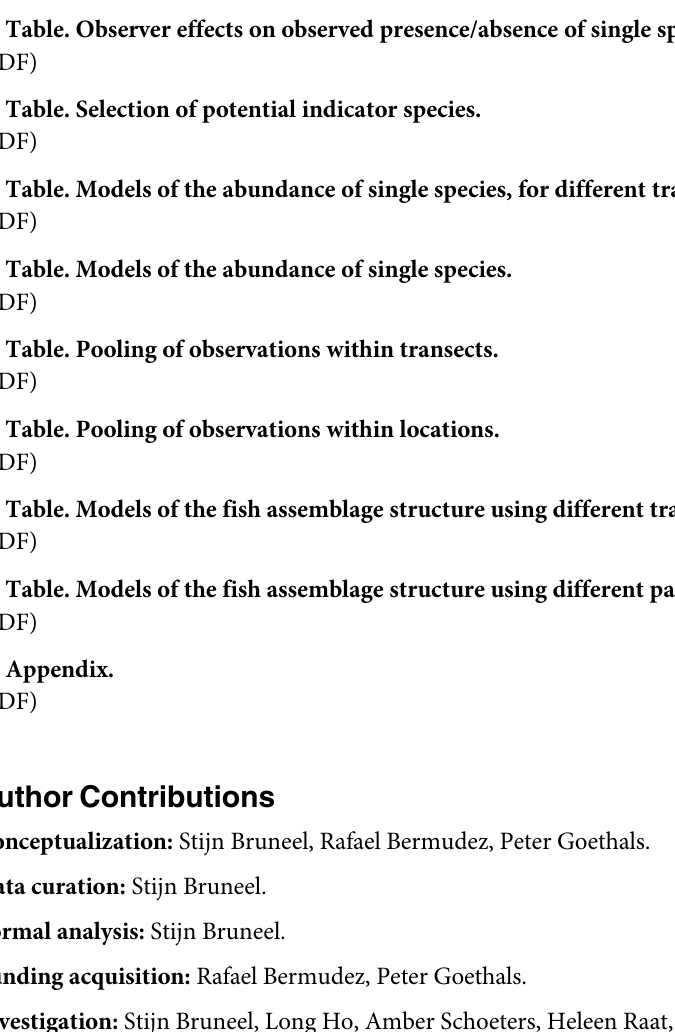
S2 Table. Observer effects on observed presence/absence of single species. S3 Table. Selection of potential indicator species. S4 Table. Models of the abundance of single species, for different transect lengths. S5 Table. Models of the abundance of single species. S6 Table. Pooling of observations within transects. S7 Table. Pooling of observations within locations. S8 Table. Models of the fish assemblage structure using different transect lengths. S9 Table. Models of the fish assemblage structure using different